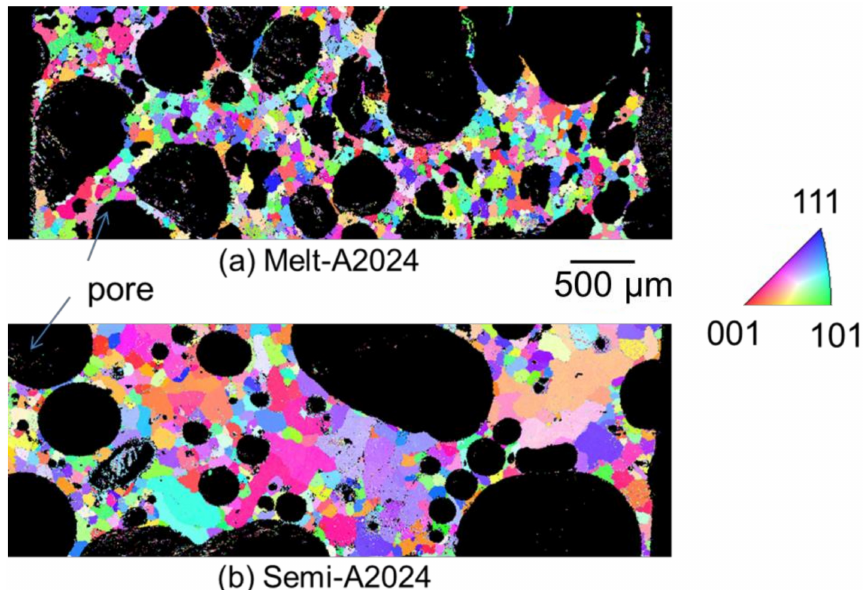
Figure 8. Inverse pole figure map. ( a ) Melt-A2024; ( b )